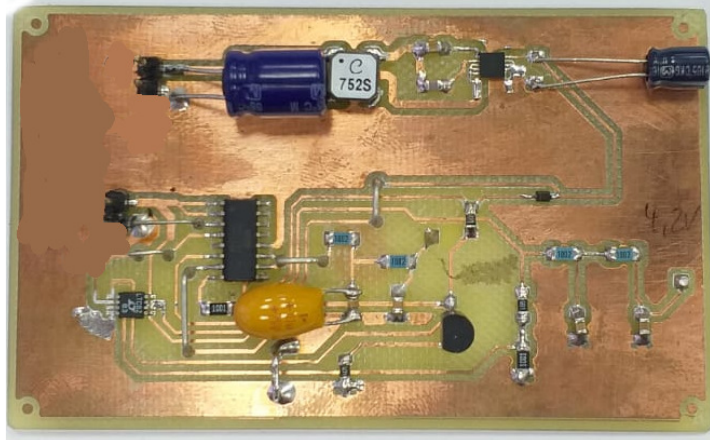
Figure 6. Photograph of the measurement circuit